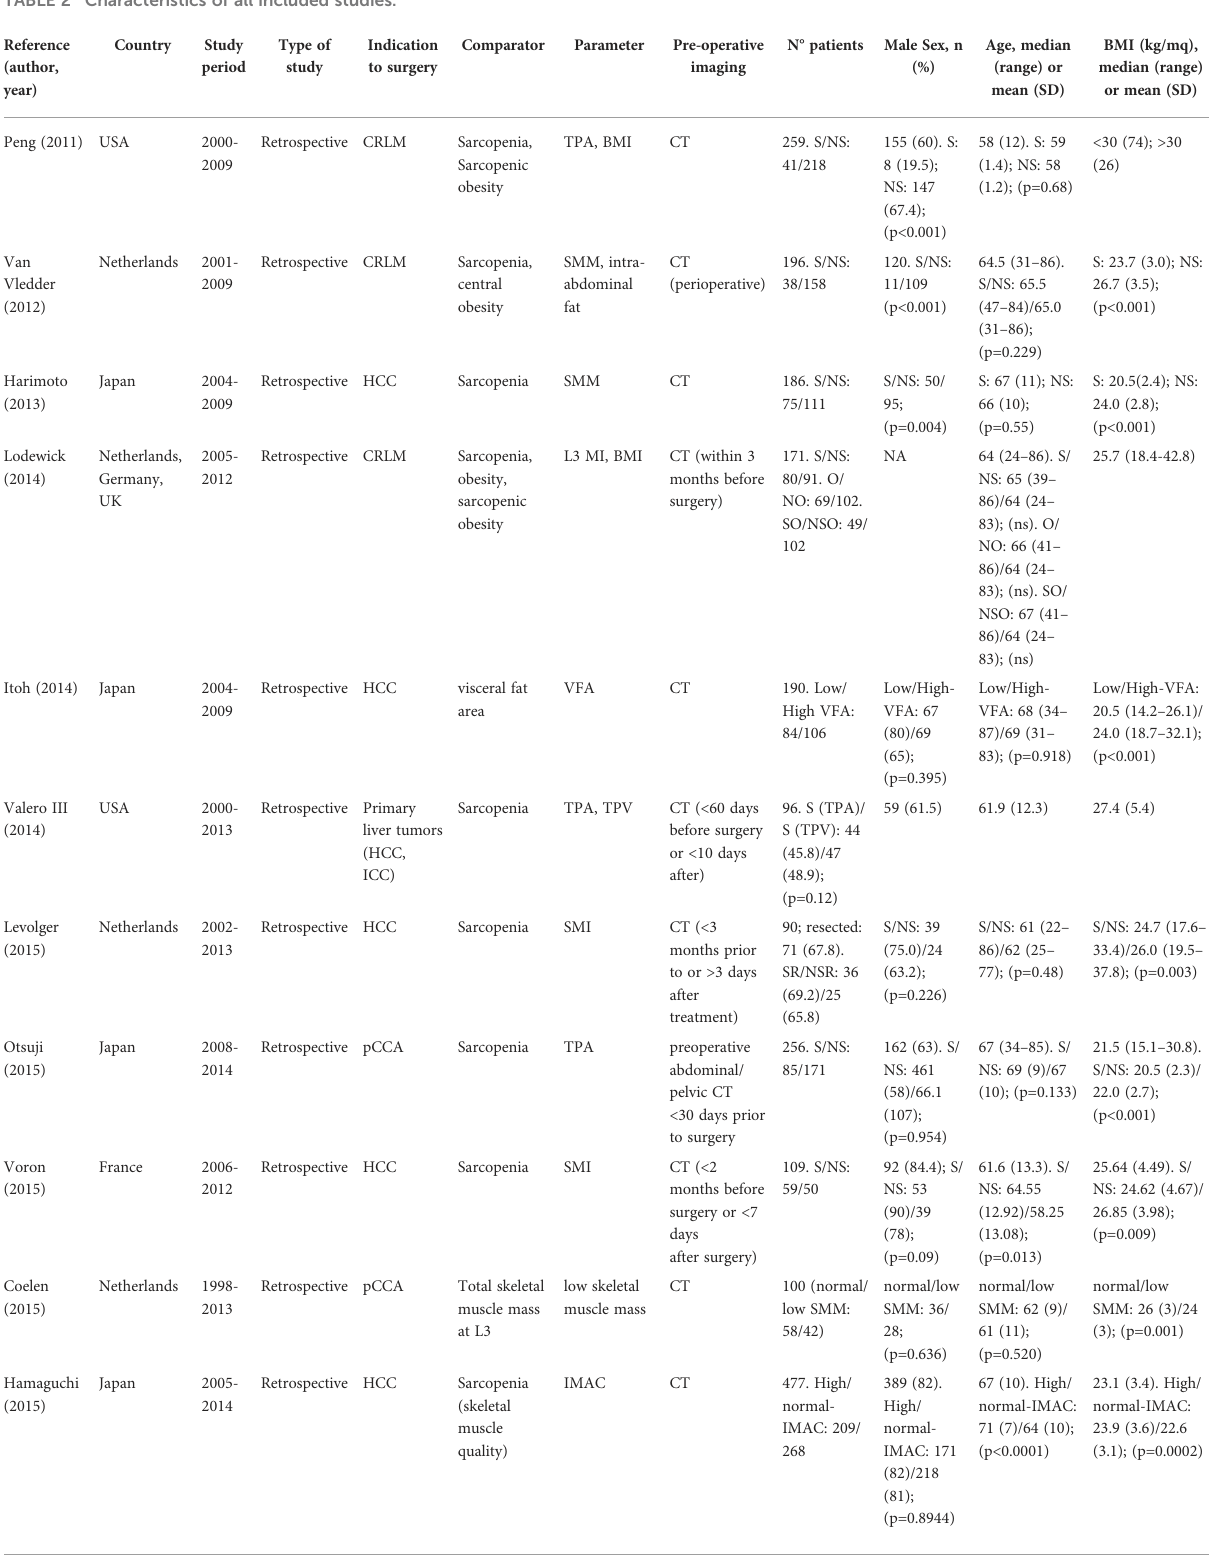
TABLE 2 Characteristics of all included